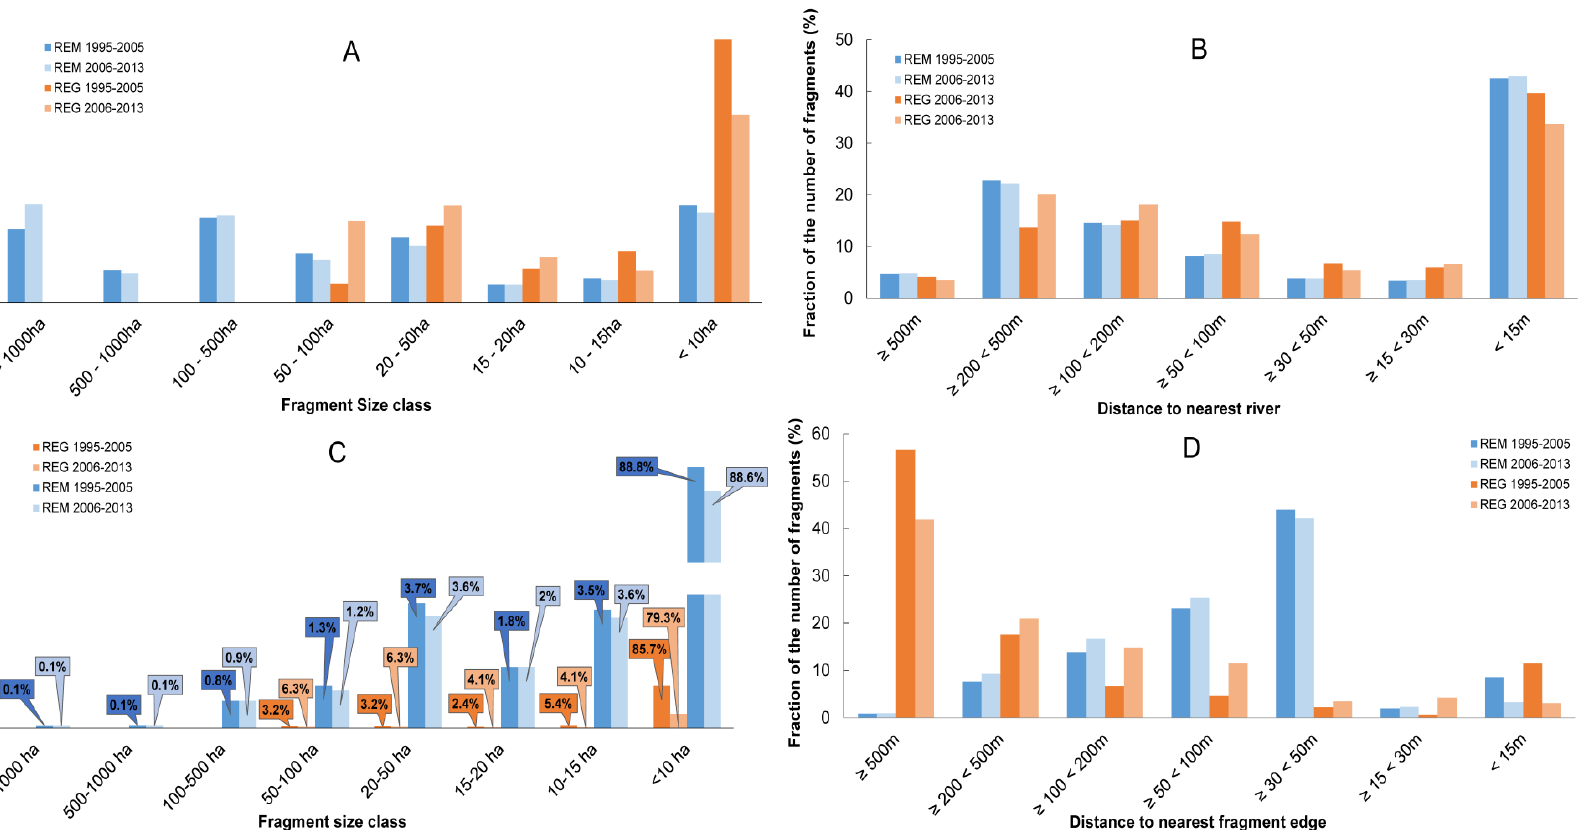
Figure 5. Forest regeneration and remnants transition classes’ metrics. ( a ) Percentage of forest cover per fragment size class. ( b ) Fraction of the number of fragments (%) according to the distance to the nearest river. ( c ) Total number of fragments and the corresponding percentage per fragments size class. ( d ) Percentage of the number of fragments according to the distance to the fragment edge.